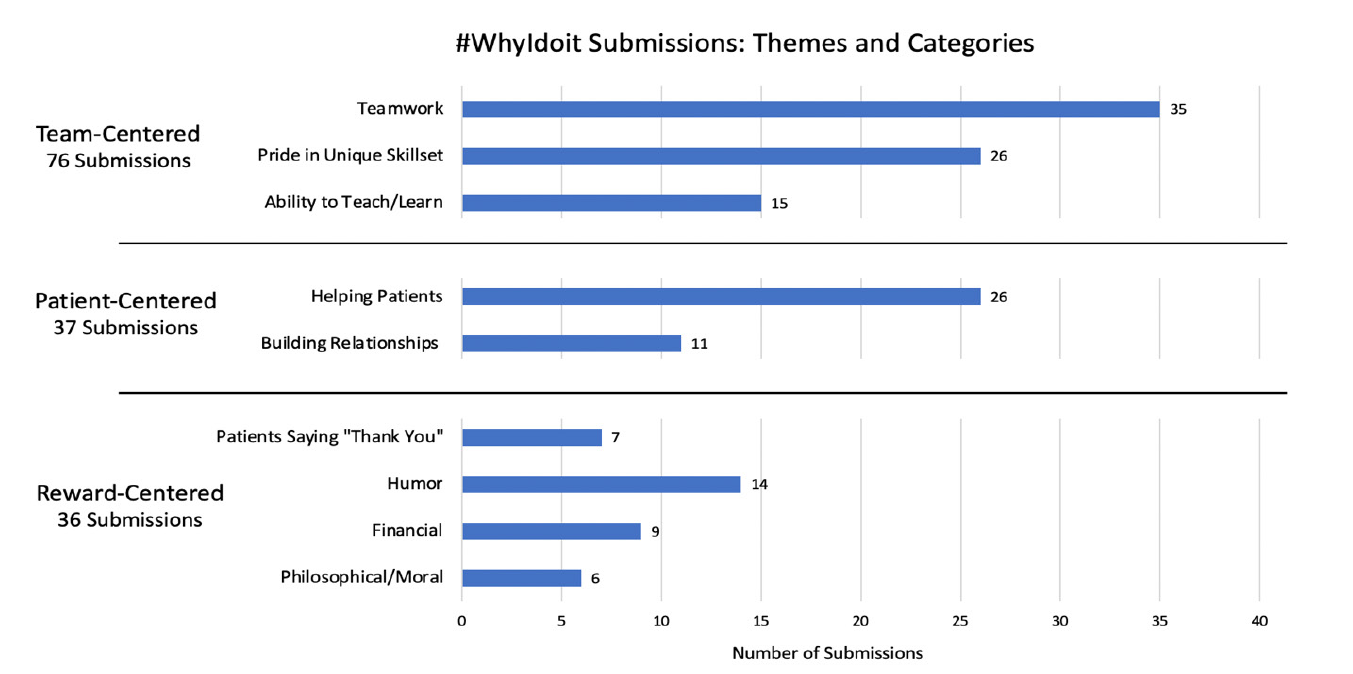
Figure. Total number of #WhyIdoit submissions per theme for team-centered, patient-centered, and reward-centered